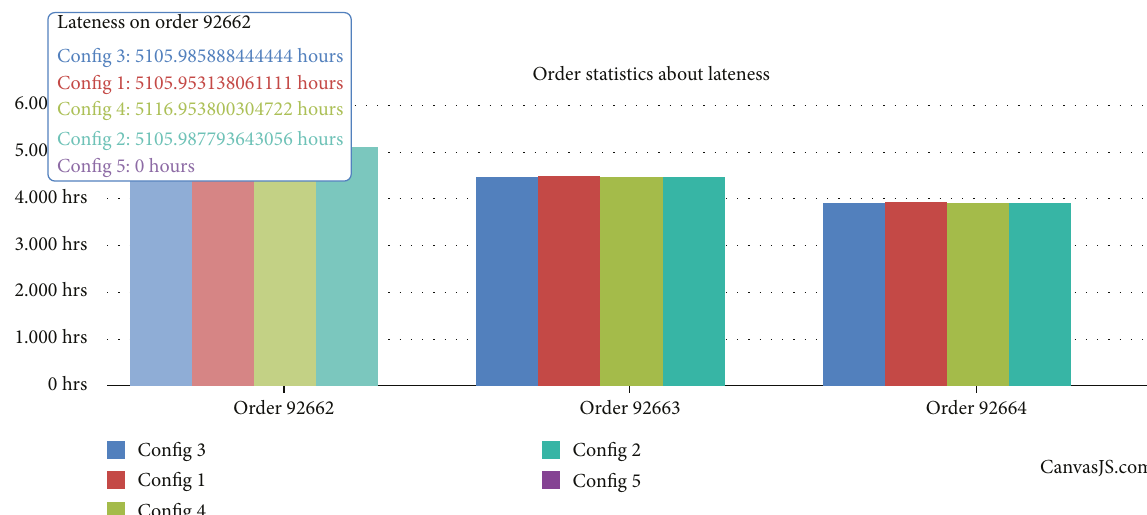
Figure 11: Statistics of the orders pulled through the system.